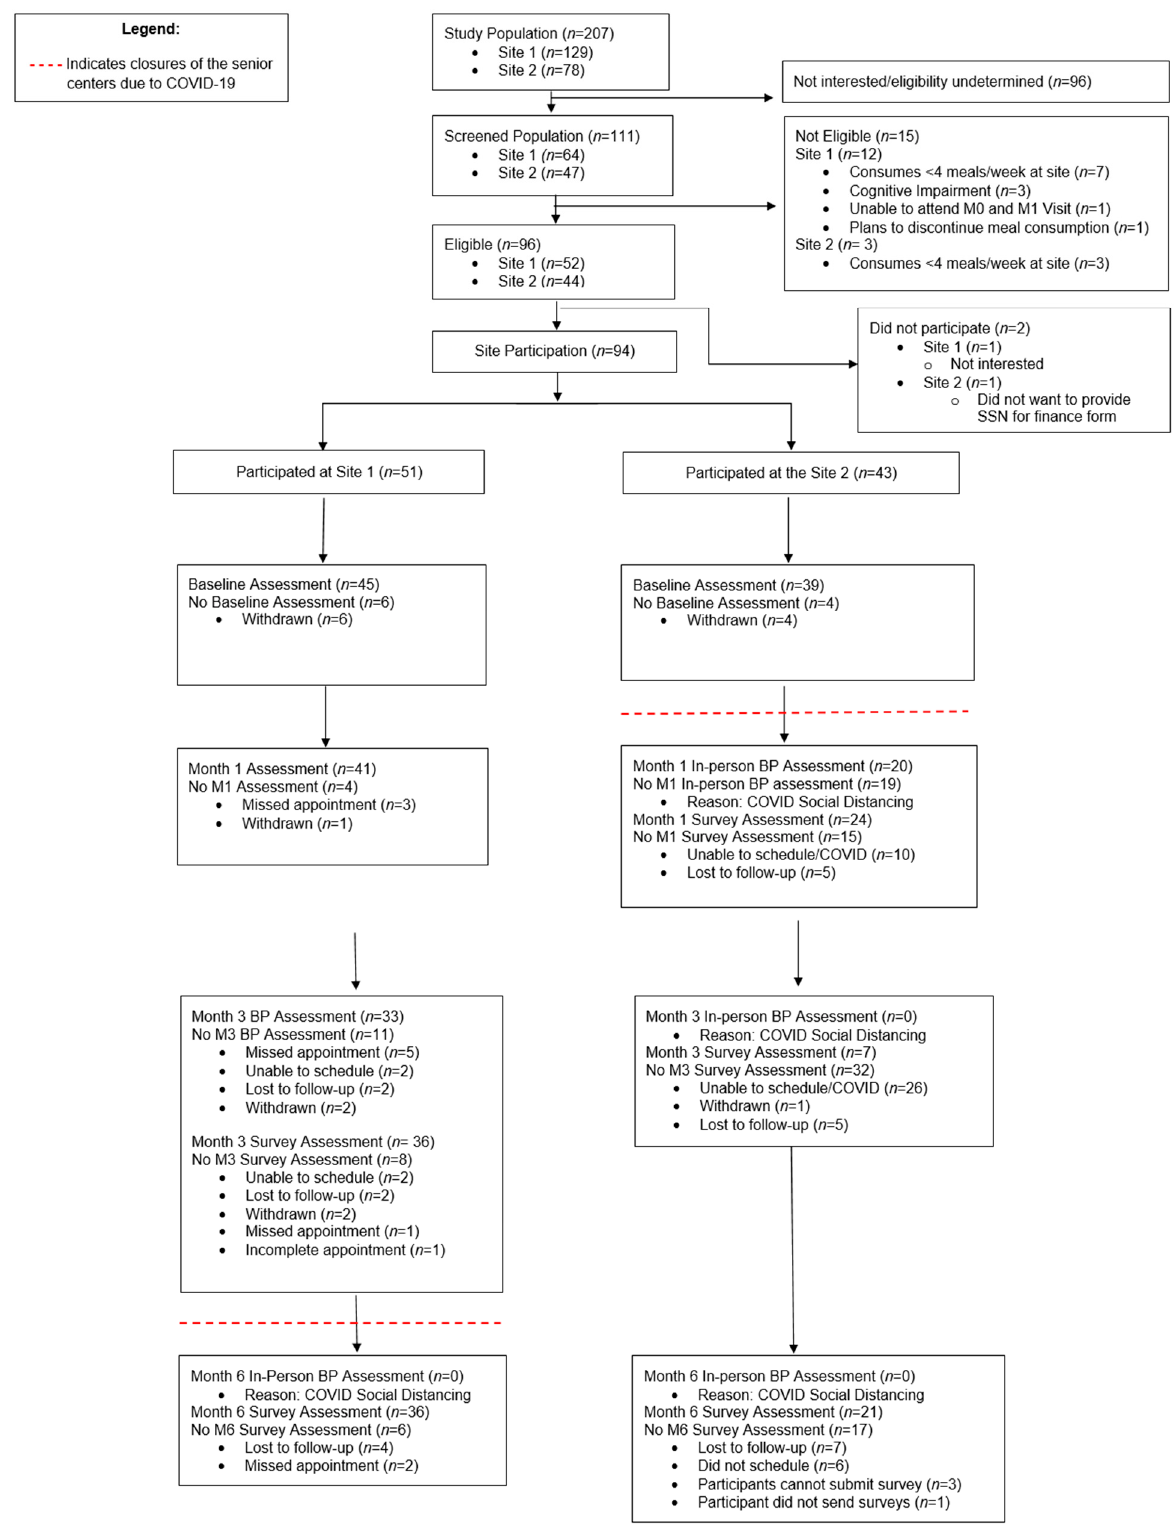
Figure 1. The CONSORT diagram shows the number of participants enrolled at each stage of the study. The closure of each study site due to COVID is also indicated reproduced from [24].